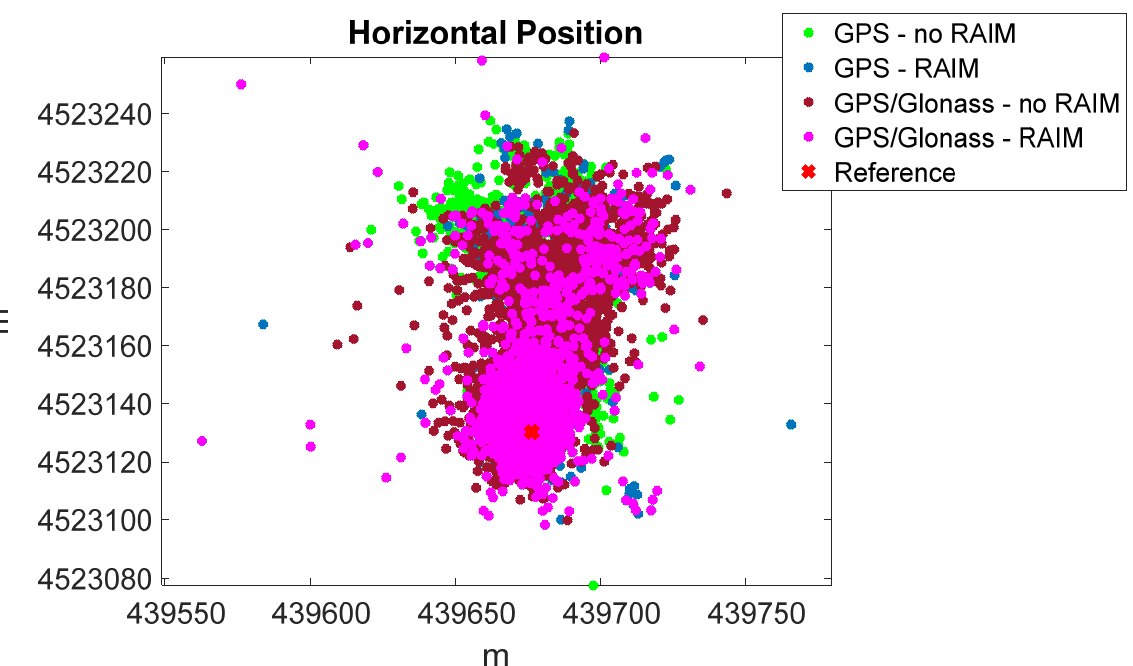
Figure 5. Horizontal position with Xiaomi Mi8, with and without RAIM application.